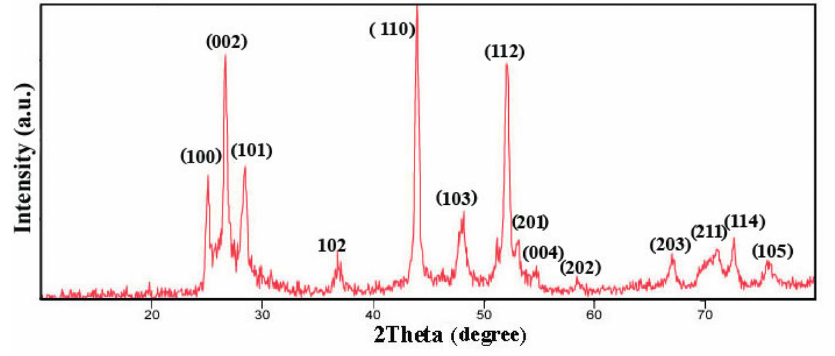
Figure 1: XRD pattern of CdS nanoparticles.